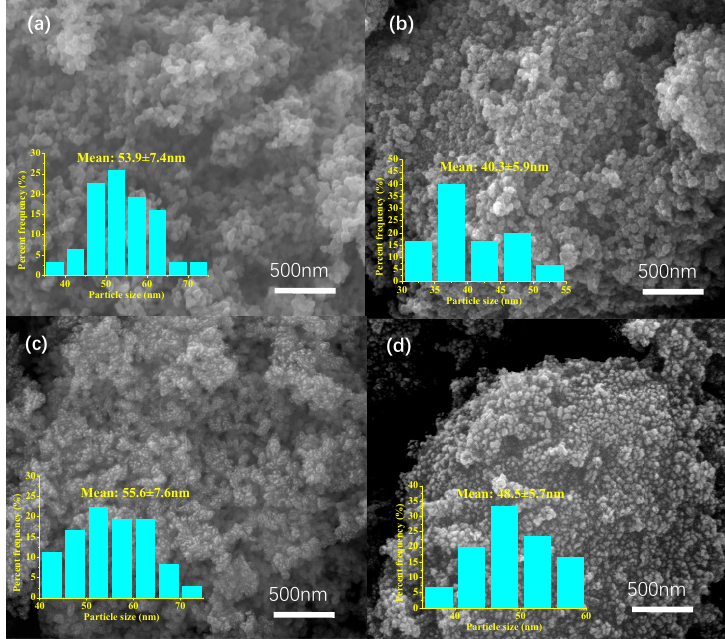
Figure 2. SEM micrographs of the rutile ( a ) and anatase TiO 2 supports ( b ) used in this study, RuO 2 /TiO 2 -r ( c ), RuO 2 /TiO 2 -a ( d ).